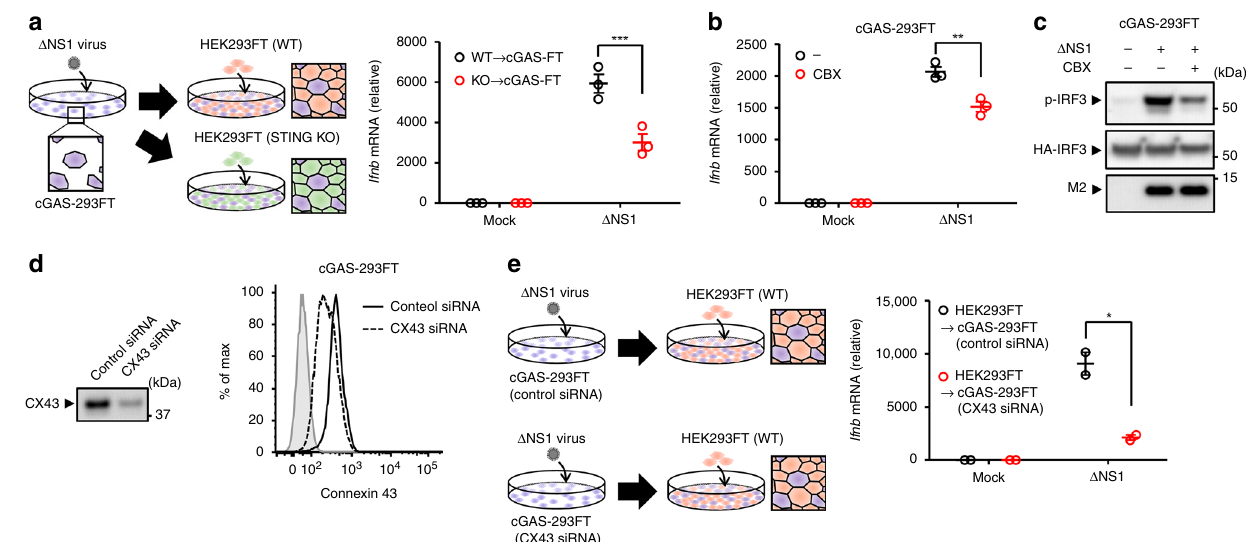
Fig. 8 Connexin 43 ampli fi es in fl uenza virus-induced STING-dependent innate immune signaling. a Schematic representation of experimental setup (left panel). cGAS-293FT cells were infected with Δ NS1 in fl uenza virus (purple). Six hours later, uninfected WT (red) or STING KO (green) HEK293FT cells were added to the Δ NS1 in fl uenza virus-infected cGAS-293FT cells (purple) and co-cultured for additional 18 h. IFN- β mRNA levels were assessed by quantitative PCR at 24 h post infection (right panel). b cGAS-293FT cells infected with Δ NS1 in fl uenza virus in the presence or absence of CBX (160 μ M). IFN- β mRNA levels were assessed by quantitative PCR at 24 h post infection. c cGAS-293FT cells were transfected with the expression plasmid encoding HA-tagged IRF3. Twenty-four hours after transfection, the cells were infected with Δ NS1 in fl uenza virus in the presence or absence of CBX (160 μ M). Cell lysates were collected at 12 h post infection and blotted using the indicated antibodies. d Samples from cGAS-293FT cells transfected with siRNA targeting connexin 43 (CX43) or control siRNA were blotted using the indicated antibodies (left panel) or intracellularly stained with CX43-speci fi c antibody and analyzed by fl ow cytometry (right panel). e Schematic representation of experimental setup (left panel). cGAS-293FT cells transfected with siRNA targeting connexin 43 (CX43) or control siRNA were infected with Δ NS1 in fl uenza virus (purple). Six hours later, uninfected HEK293FT cells (red) were added to the Δ NS1 in fl uenza virus-infected cGAS-293FT cells (purple) and co-cultured for additional 18 h. IFN- β mRNA levels were assessed by quantitative PCR at 24 h post infection (right panel). These data are from three independent experiments ( a , b , e ; mean ± s.e.m.). * P < 0.05, ** P < 0.01, *** P < 0.001; (one-way ANOVA and Tukey ’ s test). Source data are provided as a Source Data fi were co-cultured with CX43-suf fi cient HEK293FT cells (Fig. 8d,